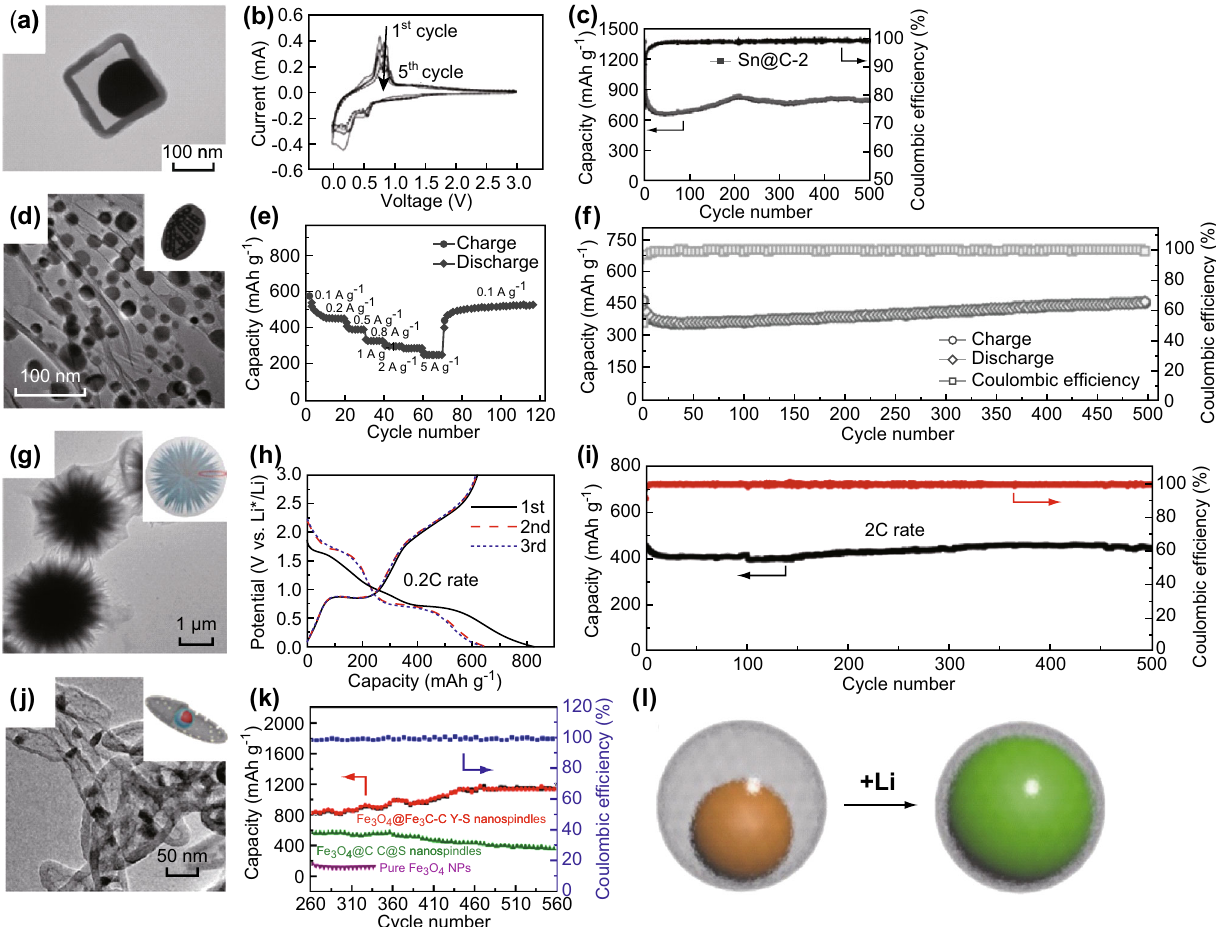
Fig. 5 TEM images and electrochemical performance of LIB assembled with YS structure anode: a Sn@C nanocube, the corresponding b cyclic voltammetry curves and c cyclic performance. Reprinted with permission from Ref. [87]. d Ni 2 P wrapped by graphene networks, the corresponding e rate performance at different current densities, and f long-term cycle performance. Reprinted with permission from Ref. [124]. g urchin-like Bi 2 S 3 @ppy, the corresponding h galvanostatic profiles and i long-term cyclic performance. Reprinted with permission from Ref. [72]. j